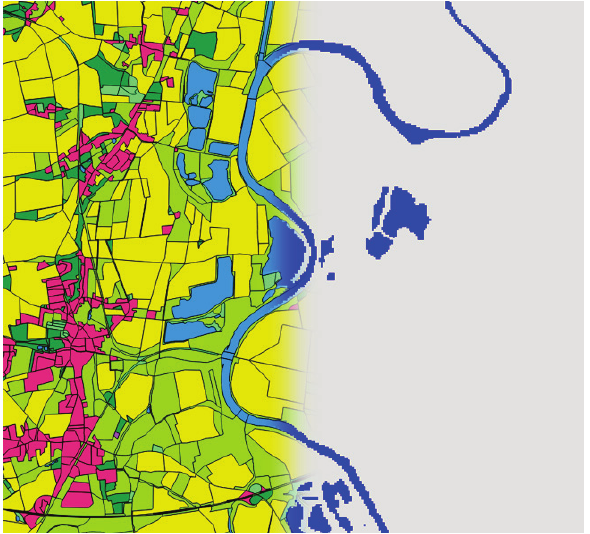
Figure 2: Derivation of the HRL permanent water bodies from